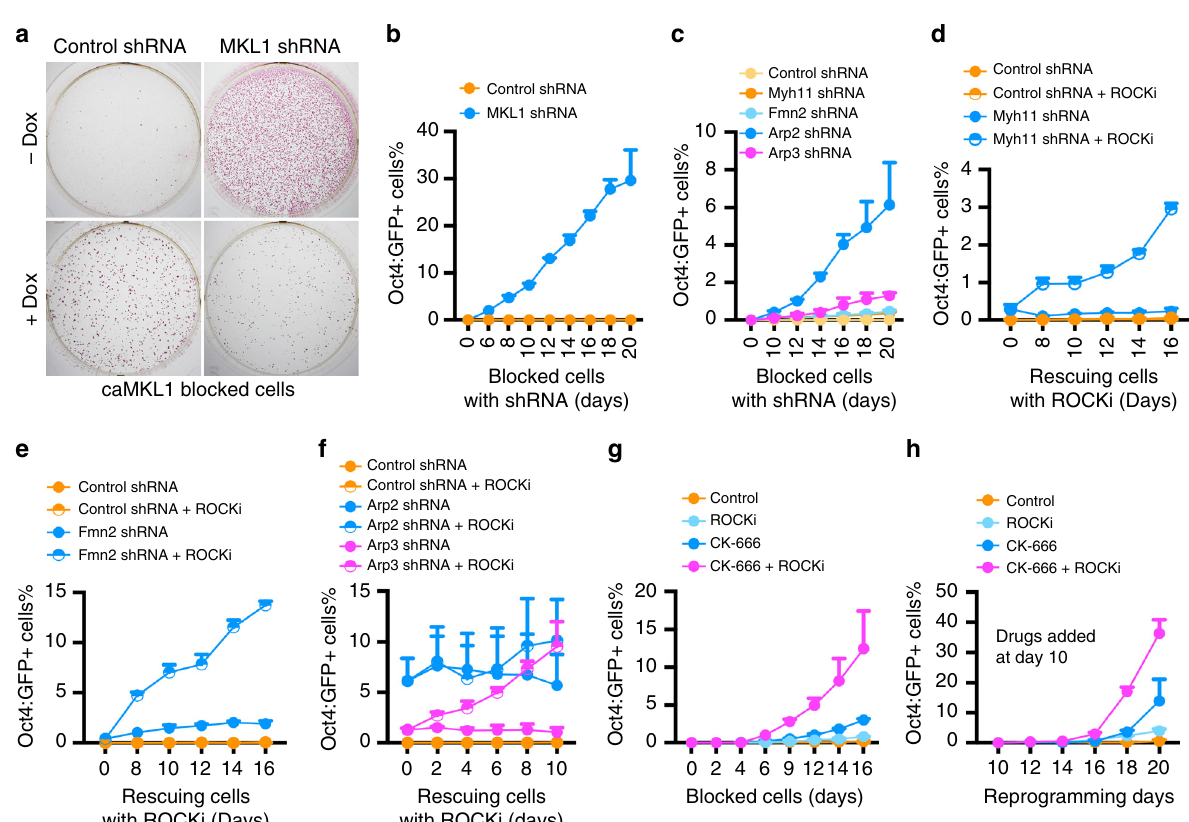
Fig. 3 Actin polymerization is required for caMKL1-mediated block of mature pluripotency activation. a AP staining of caMKL1-expressing cells transduced with control or MKL1-targeting shRNA, cultured with or without Dox. Staining was performed 15 days after viral transduction. b – f Percentage of Oct4:GFP + cells emerging from blocked cells following treatment of control or MKL1-targeting shRNAs ( b ); control or Myh11-, Fmn2-, Arp2- or Arp3-targeting shRNAs ( c ); control or Myh11-targeting shRNAs, with or without ROCKi ( d ); control or Fmn2-targeting shRNAs, with or without ROCKi ( e ); control or Arp2- or Arp3-targeting shRNAs, with or without ROCKi ( f ). d – f ROCKi was added at day 20 of shRNA treatment. g Percentage of Oct4:GFP + cells emerging